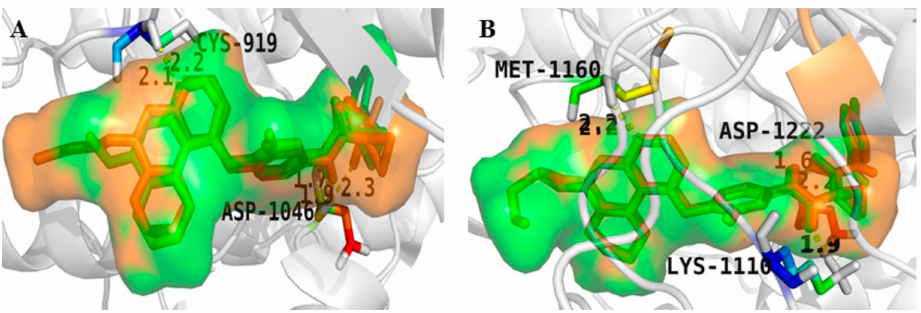
Figure 12. ( A ) The model of compounds 20 (green) and 21 (orange) bound to VEGFR-2 (PDB code: 3U6J); ( B ) The model of compounds 20 and 21 bound to c-Met (PDB code: